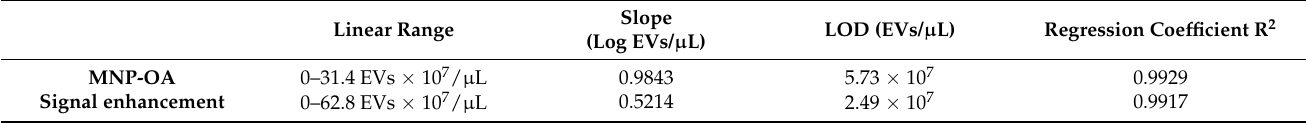
Table 1. Comparison of the different LODs obtained with the LFIA using magnetic nanoparticles coated with oleic acid and after signal enhancement (nanozyme-mediated